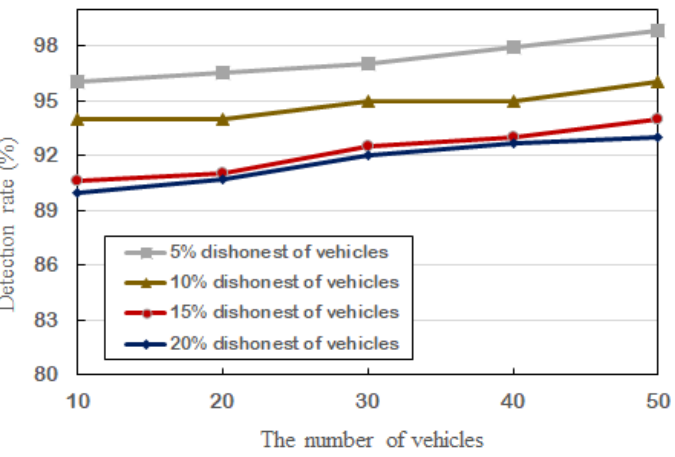
Figure 5. The detection rate and corresponding